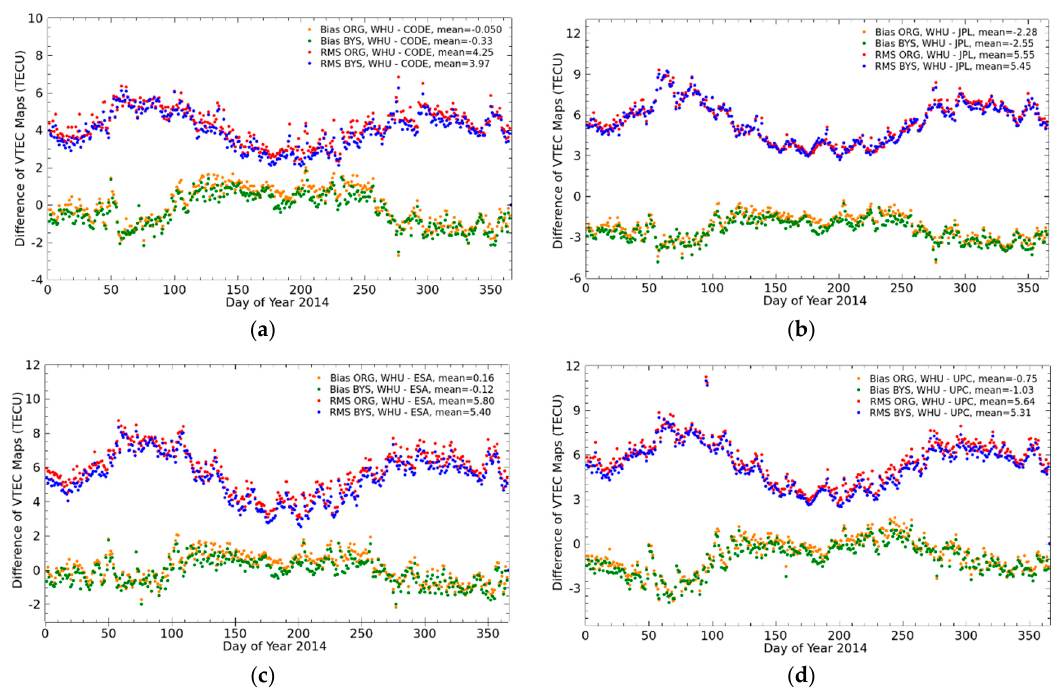
Figure 6. Differences between VTEC maps and IAAC GIMs. The red points and blue points show the RMSs of differences in VTEC maps based on original LSE and Bayesian, respectively, compared with IAAC GIMs. ( a ) Compared with Center for Orbit Determination in Europe (CODE). ( b ) Compared with Jet Propulsion Laboratory (JPL). ( c ) Compared with European Space Agency (ESA). ( d ) Compared with Technical University of Catalonia (UPC). Table 1. Differences in VTEC maps based on original LSE and Bayesian approaches compared with IAAC GIMs (unit: TECU).